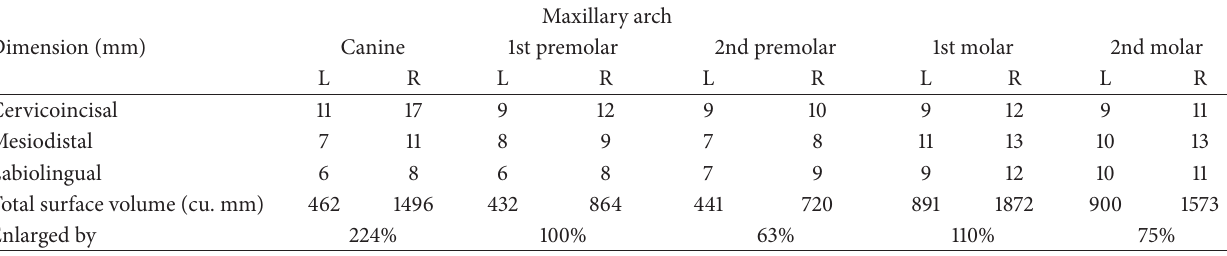
Table 1: Comparison of crown sizes of the maxillary teeth.